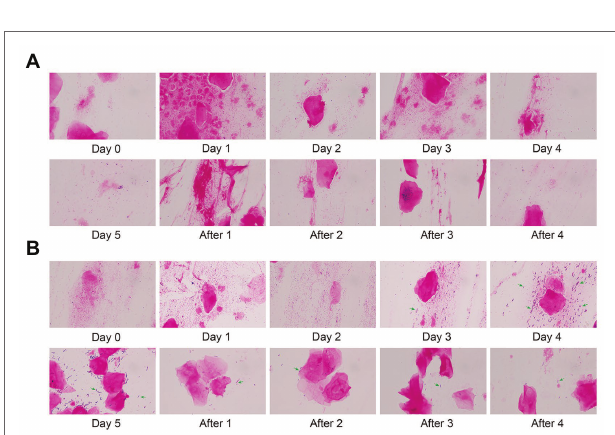
FIGURE 6 | Gram stain of vaginal microbiota before and after gel treatment. (A) The morphology of Subject 5 (control group) under 1,000× magnification after gram staining during placebo gel treatment and withdrawal. (B) The morphology of Subject 16 (test group) during maltose gel treatment and withdrawal. Green arrows indicate Lactobacillus